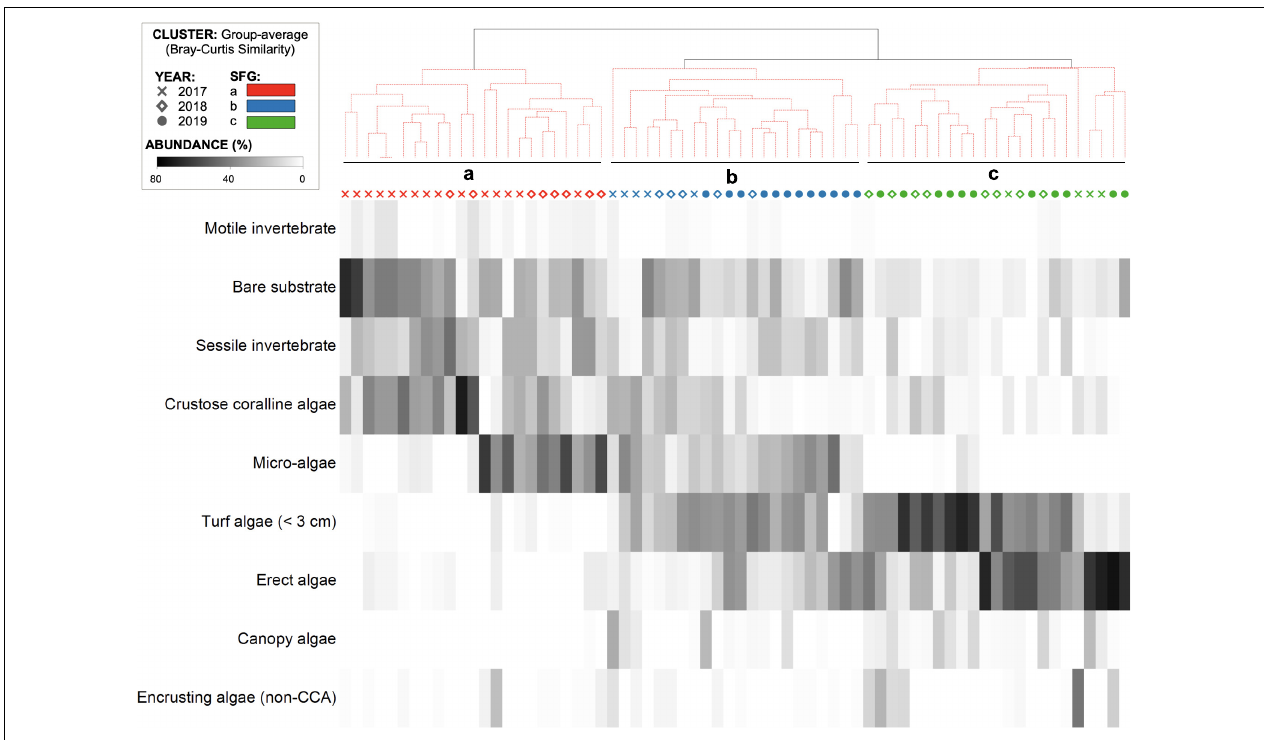
FIGURE 4 | Hierarchical cluster analysis (top) of Bray-Curtis similarities in benthic transect samples for each of the three considered years (2017, 2018, 2019; shapes) with SIMPROF-routine generated groups (SFG = a, b, and c; colors) and sessile functional groups relative density (individuals/100 m 2 ; shade plot).